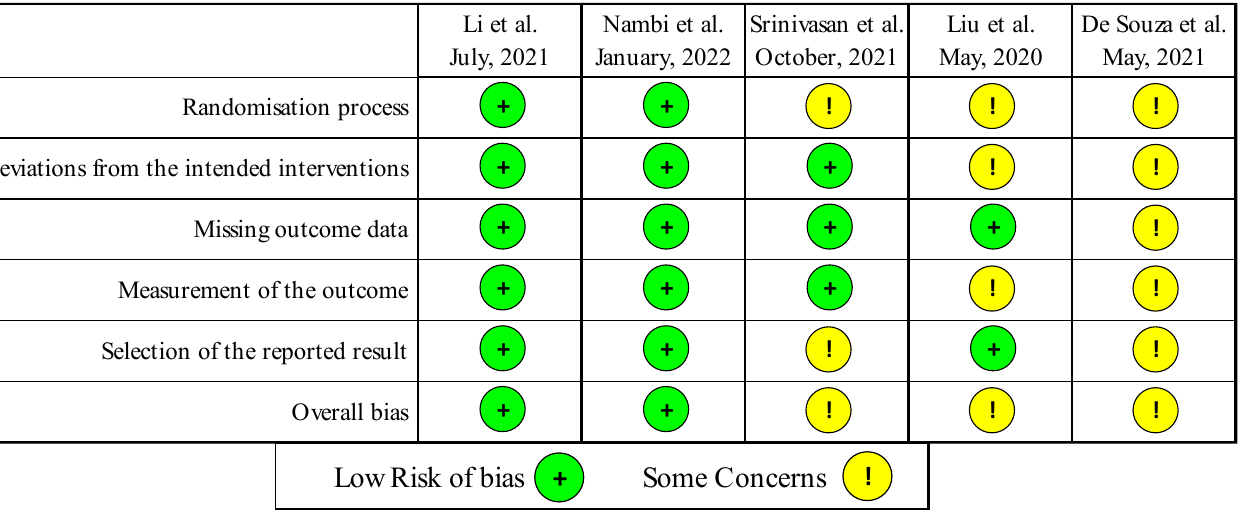
Figure 2. Risk of bias summary: review authors’ judgements about each risk of bias item for each included study.